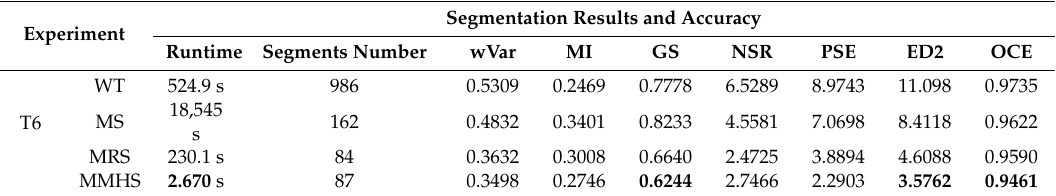
Table 10. The quantitative assessment results of the Potsdam aerial image (T6).